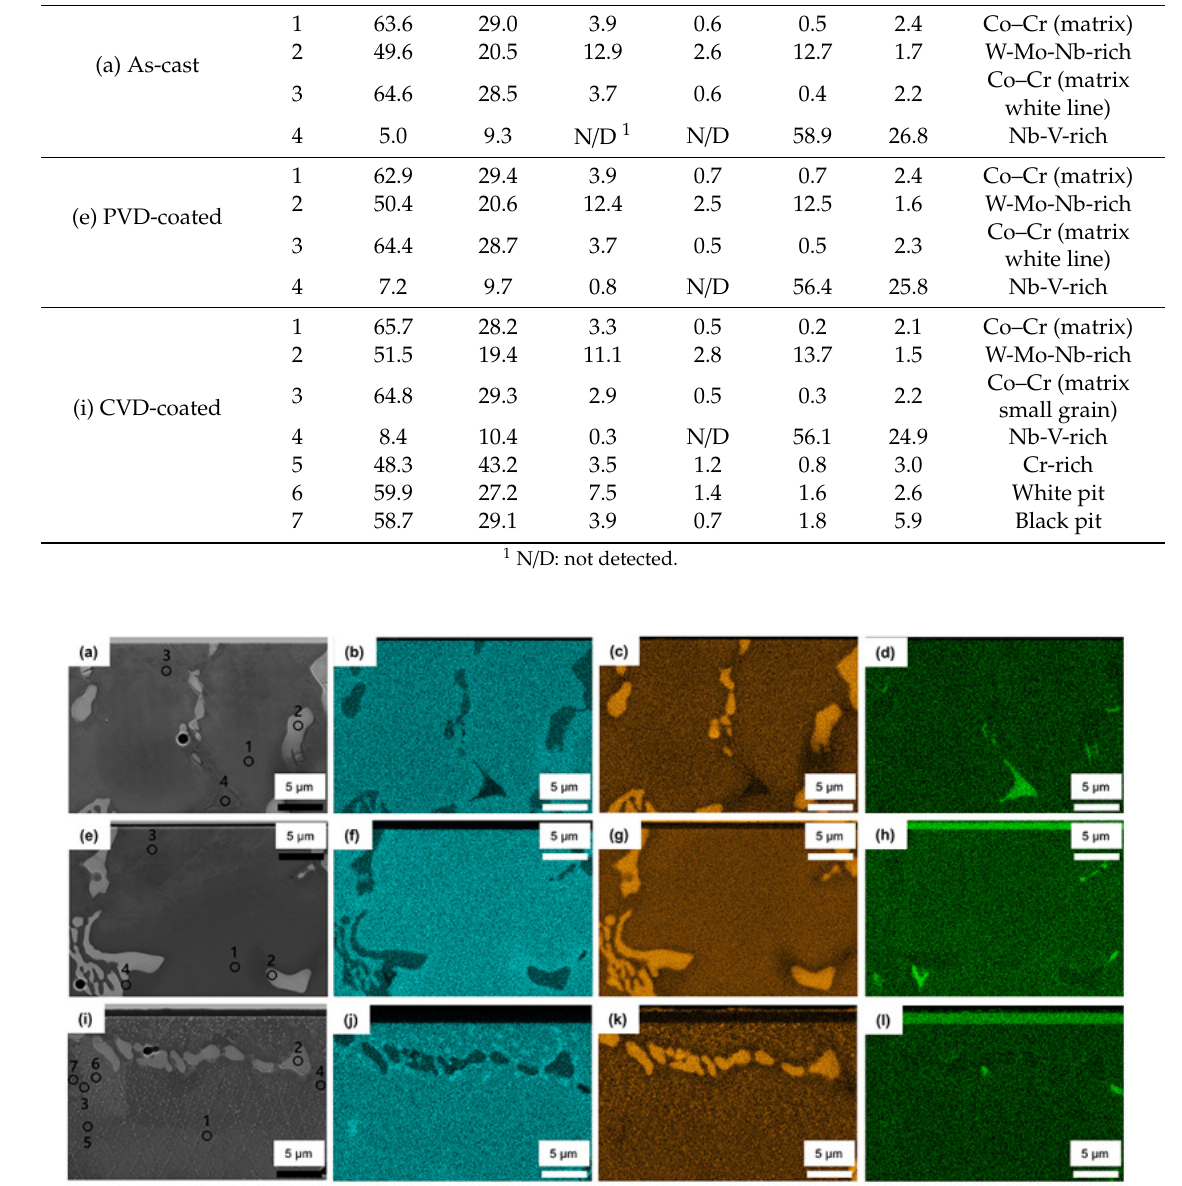
Figure 7. Cross-sectional SEM micrographs of the three groups ( a , e , and i ) and their corresponding EDS mapping images (( b , f , and j ): Cr; ( c ), ( g ), and ( k ): W; and ( d ), ( h ), and ( i ): V) of the Co–Cr alloys (as-cast) ( a – d ) and PVD ( e – h ) and CVD ( i – l ) TiN-coated alloys (up to 20 μ m from the interface, 3000×). The bright regions seen at the top of images ( h ) and ( l ) indicate Ti, which is superimposed with V. The circlets seen in images ( a ), ( e ), and ( i ) indicate the points for the EDS spot analysis (see Table 2). Table 2 shows the results of the EDS point analysis for the points marked in images (a), (e), and (i) of Figure 7. The substrate phase of the as-cast and PVD TiN-coated alloys showed similar compositions in similar microstructure regions, the scratch-like or white lines showing the same composition as in the matrix phase (points 3 of (a) and (e)). In the CVD-coated alloy (i), the composition of point 3, showing a matrix of small grains approximately 10 μ m below the interface, was not significantly different from that of point 1. Although the as-cast alloy also showed some Cr- rich area between the dendrite and matrix as well as in the matrix (see also Figure 3c), the frequency of Cr-rich area was sparse relative to the CVD TiN-coated alloy. A compositional analysis of points 6 and 7 of (i) revealed little difference in the amounts of matrix Co and Cr, while the amount of W and V was relatively high in the white pits and in the black pits, respectively. In this point analysis of the pits, the analysis range of the EDS was larger than the size of the pits, so that the results also reflect the surrounding composition. In fact, the white pits and the black pits looked like intermediate phases of being transformed into W-Nb and Nb-V precipitates, respectively. This is probably because the CVD coating was performed in the aging temperature range where precipitation or phase transformation occurs in Co–Cr alloys (Table 1). Table 2. Results of the EDS spot analysis showing the atomic weight (at%) composition ratios for the points marked in images (a), (e), and (i) of Figure 7. Image